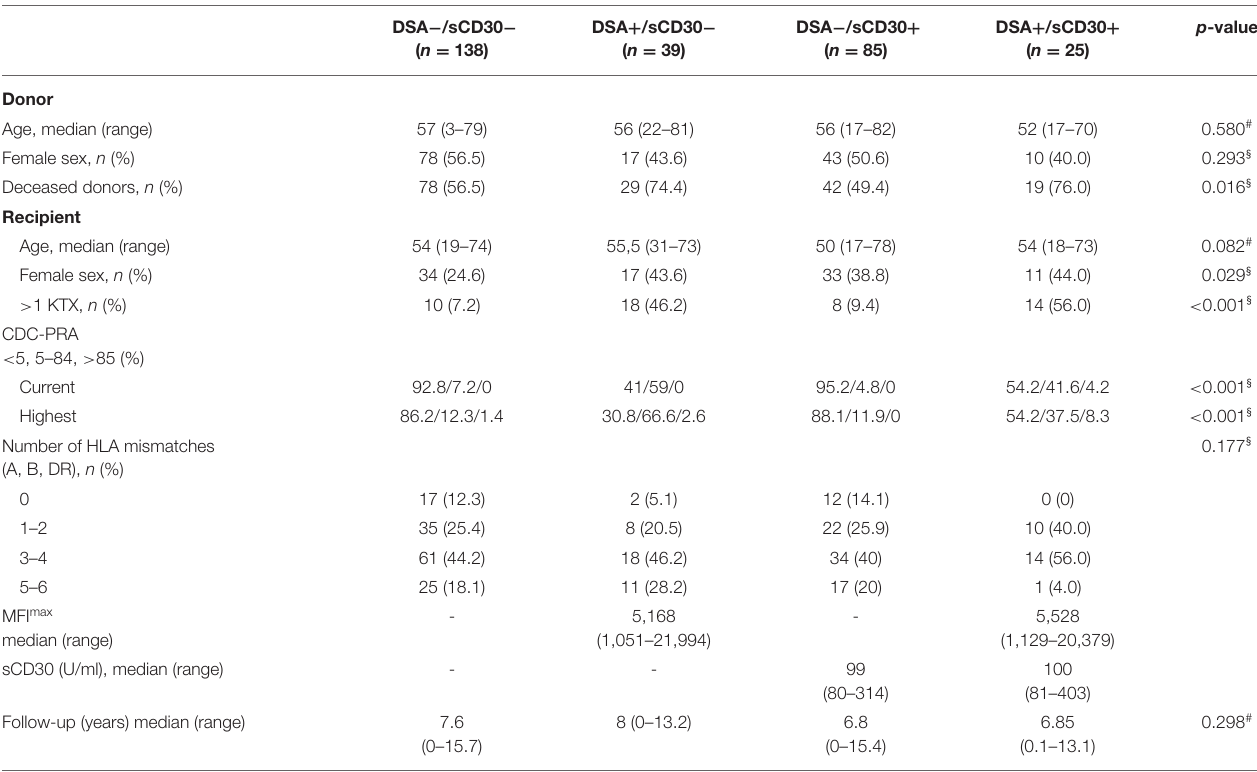
TABLE 1 | Baseline characteristics ( n =